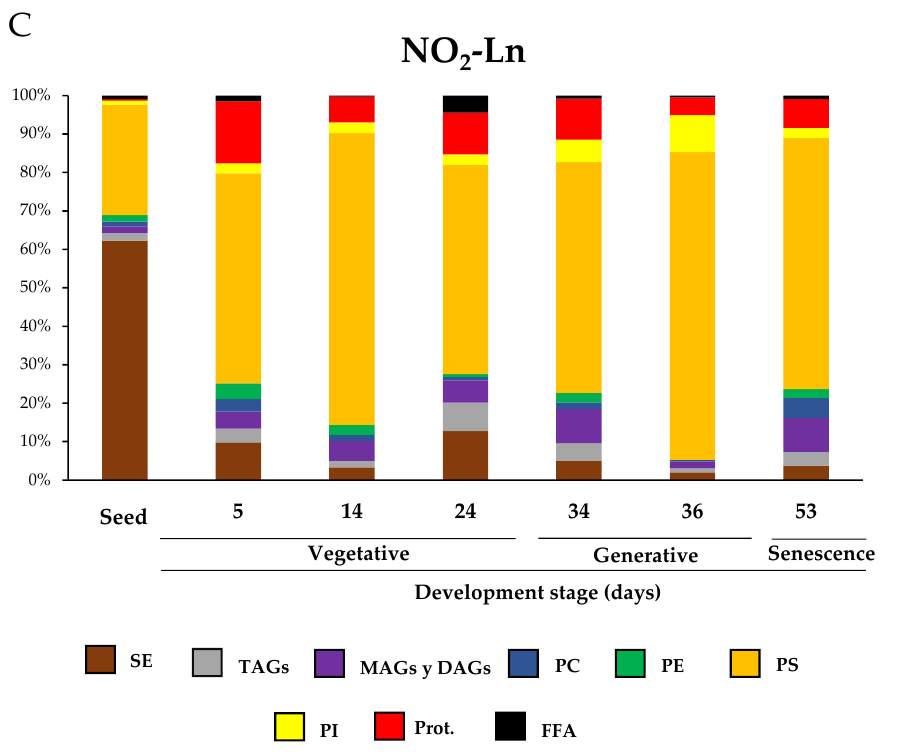
Figure 5. The relative distribution of NO 2 -FAs in the different storage biomolecules during Ara- bidopsis development. Graphs show NO 2 -FAs as the storage biomolecules (NO 2 -OA in panel ( A ); NO 2 -LA in panel ( B ); NO 2 -Ln in panel ( C )) for each developmental stage and how this distribution is modulated during development. The seeds and plants corresponding to the vegetative (5-, 14-, and 24-day-old plants), generative (34- and 36-day-old plants) and senescence stages (53-day-old plants) were used to characterize Arabidopsis development. The 100% corresponds to the total content of each NO 2 -FA and its distribution in biomolecule storages in each of the development situations